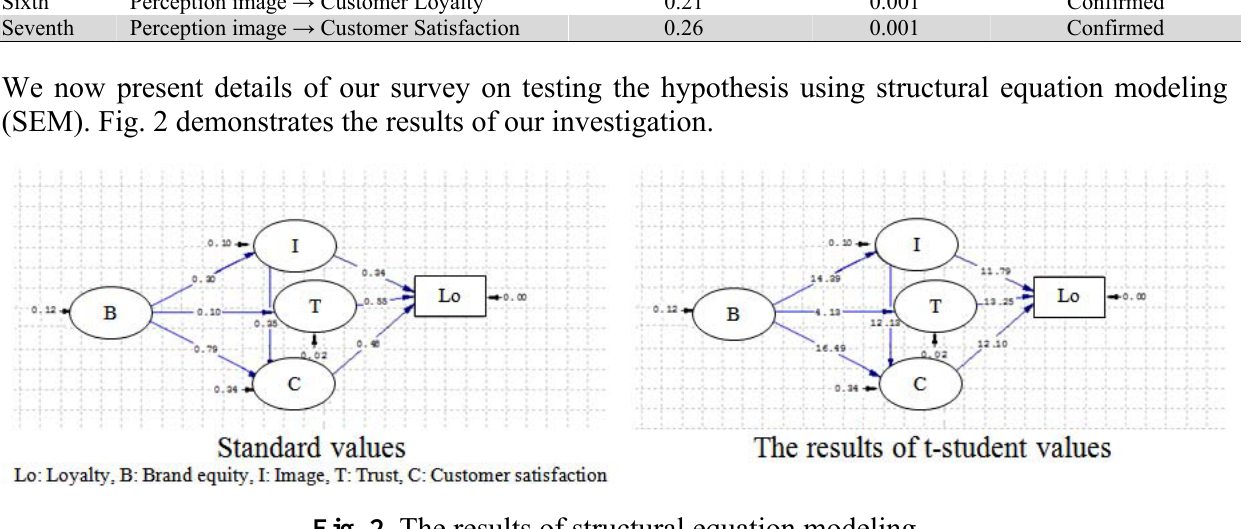
Fig. 2. The results of structural equation